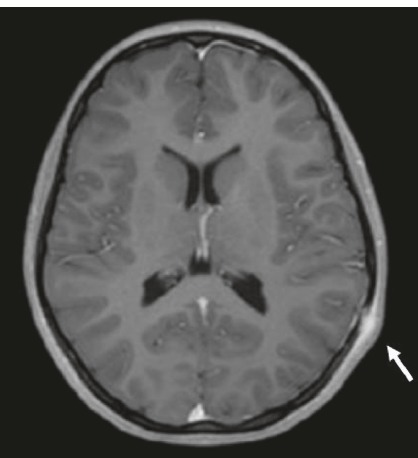
Figure 1: Cranial magnetic resonance imaging with contrast: in the left temporoparietal area in correspondence with clinical painful swelling is present an erosion of the skull of about 10mm. The external periosteum is thickened with marked contrast enhance- ment in a 4cm